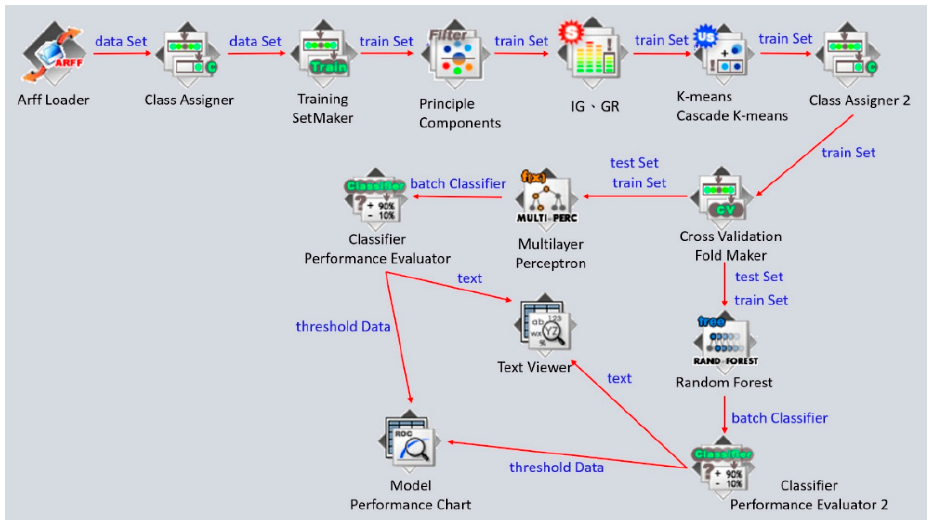
Figure 3. Clustering and classification validation with WEKA.